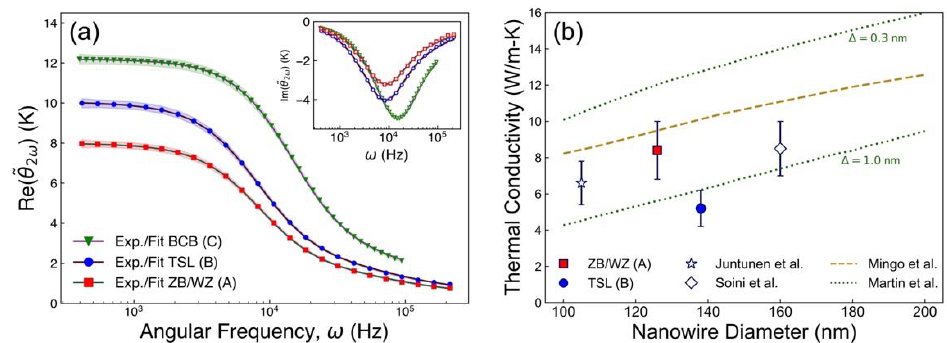
Figure 4. ( a ) Measured temperature amplitudes for samples A, B, and C, along with fitted curves, for the in-phase and out-of-phase (inset) components of each. ( b ) Thermal conductivity of GaAs NWs, with the polytypic ZB/WZ NWs (red, sample A) and the TSL NWs (blue, sample B) data points corresponding to measurements in panel ( a ). For comparison, the white markers indicate the experimental results of Juntunen et al. [17] and Soini et al. [15]. The dashed and dotted lines represent theoretical results from Mingo et al. [55] and Martin et al. [56], respectively, with ∆ indicating surface roughness for the latter.